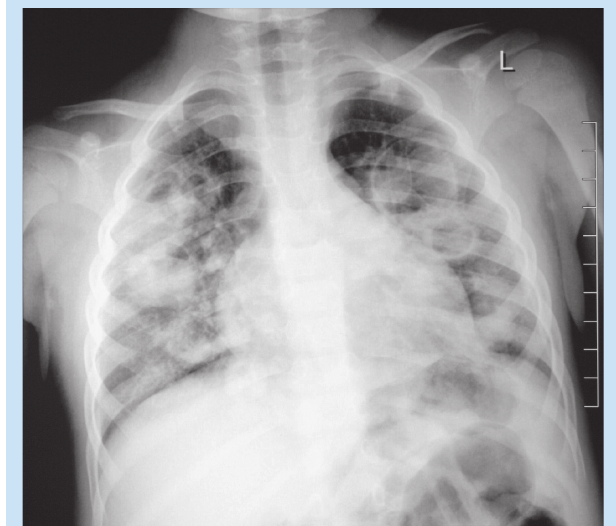
Fig. 4. Follow-up CXR after 3 months, demonstrating improvement of the pulmonary cysts.